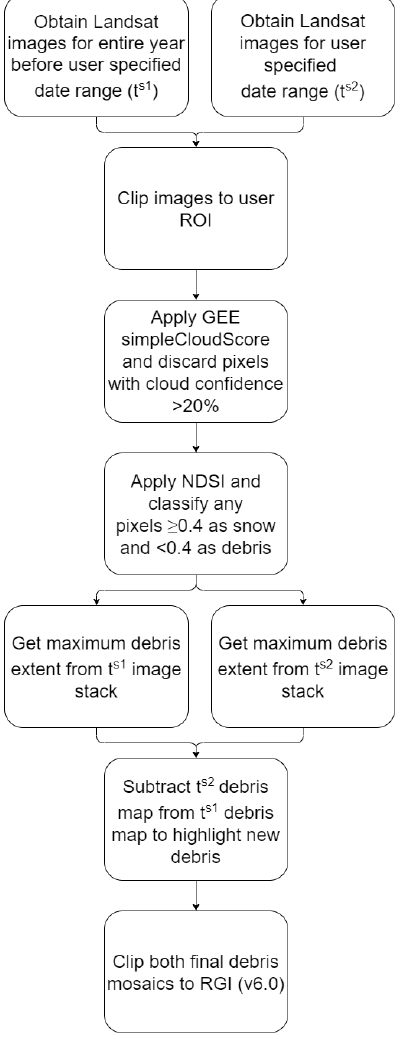
Figure 1. Processing flow of